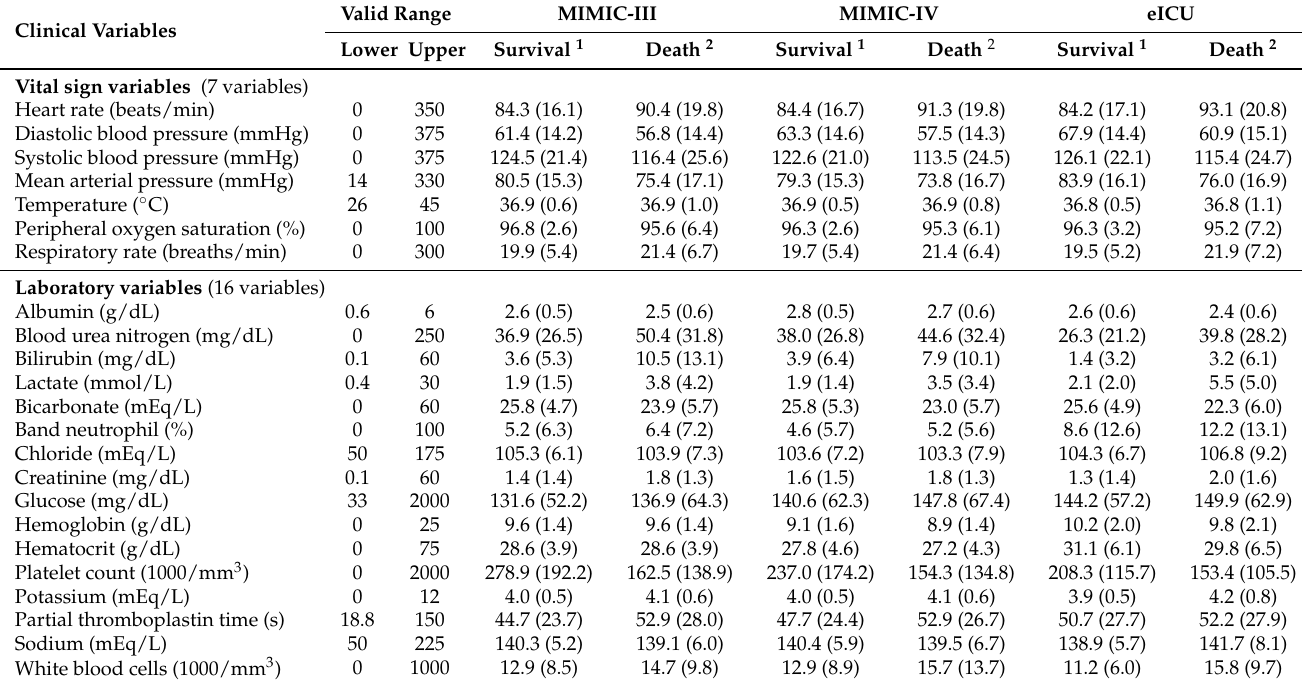
Table 2. The distribution of the values of each variable employed in our models. All variables are present in every dataset. Clinical